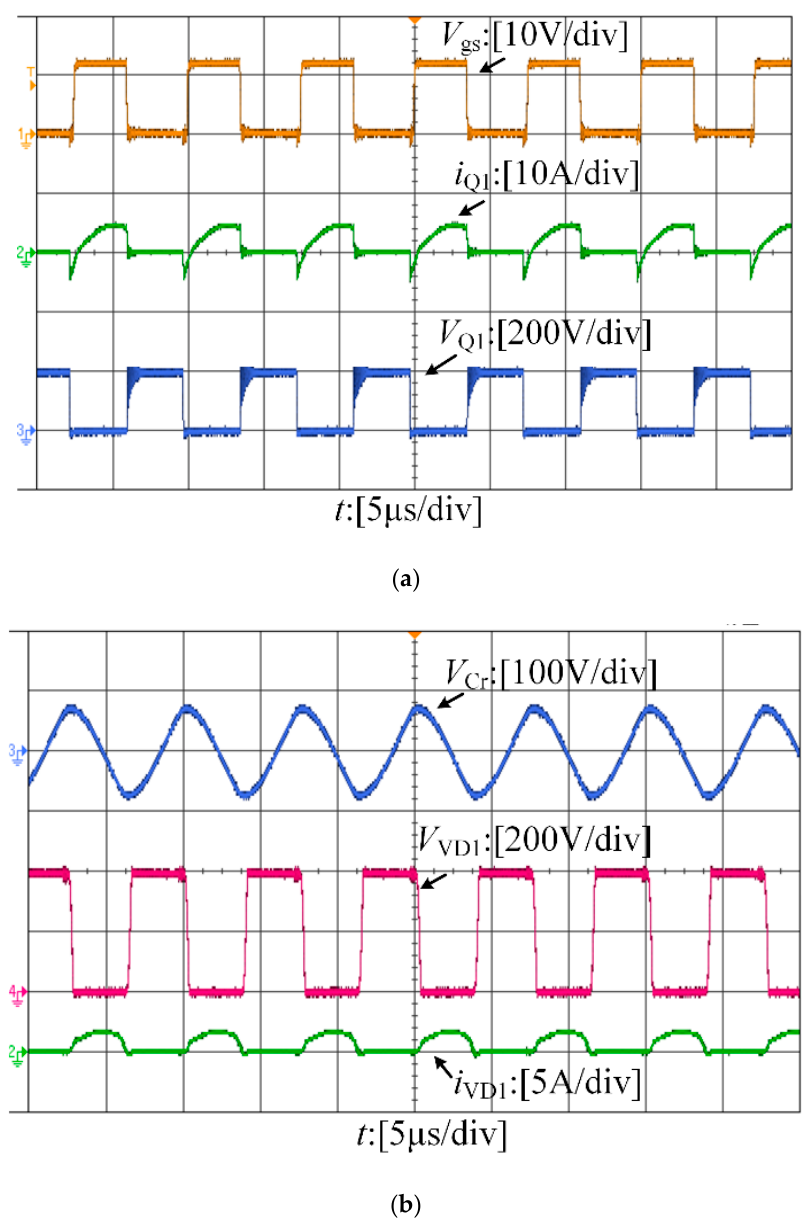
Figure 15. Experimental waveforms at point ② in mode I. ( a ) Waveforms of Q 1 . ( b ) Waveforms of VD 1 and C r